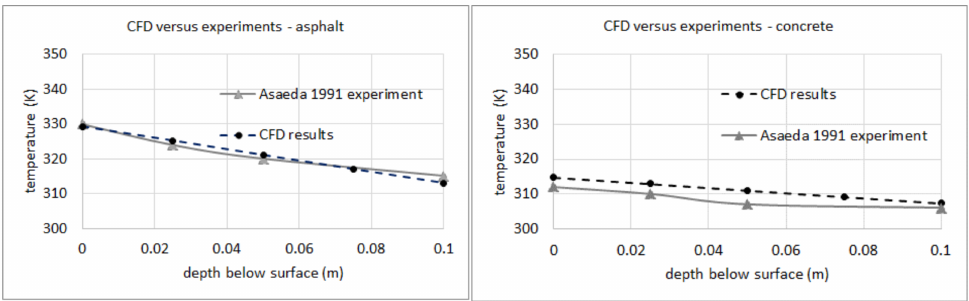
Figure 5. Validation of CFD results against experimental results shown by previous